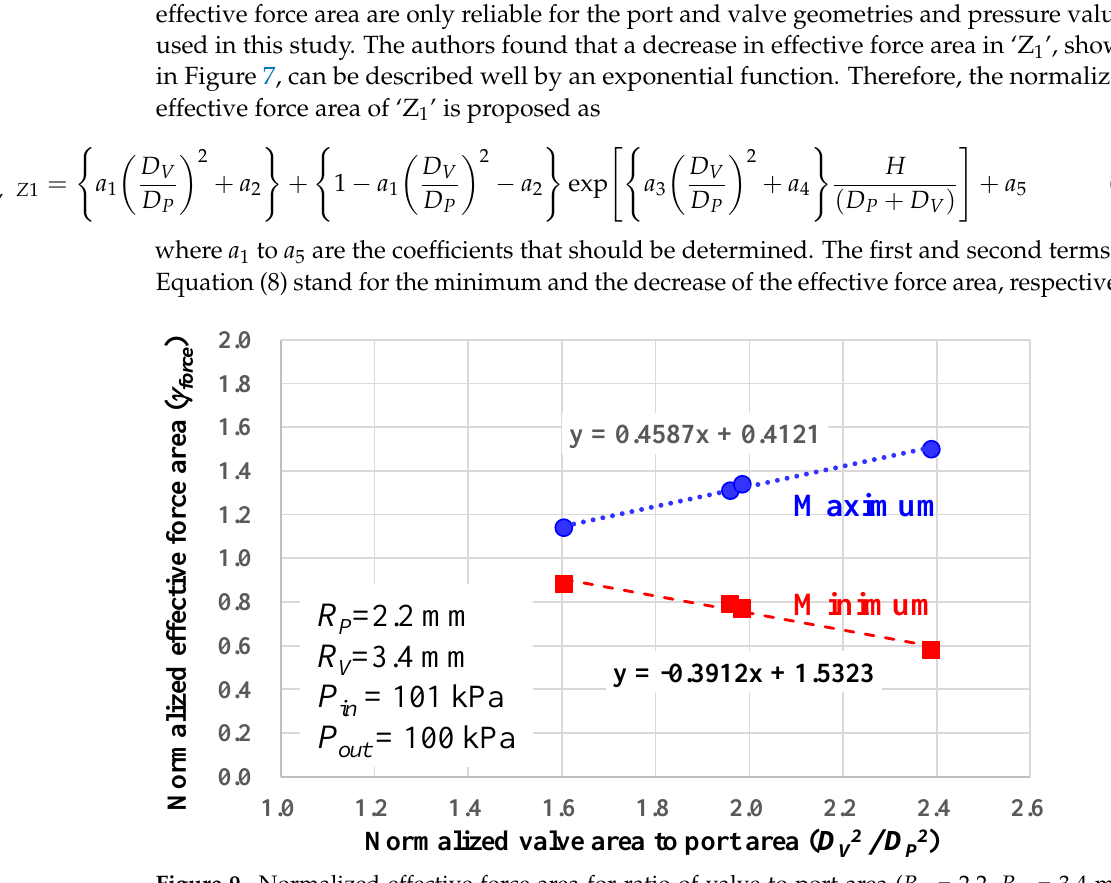
Figure 9. Normalized effective force area for ratio of valve to port area ( R P = 2.2, R V = 3.4 mm, ∆ P = 1.0 kPa).